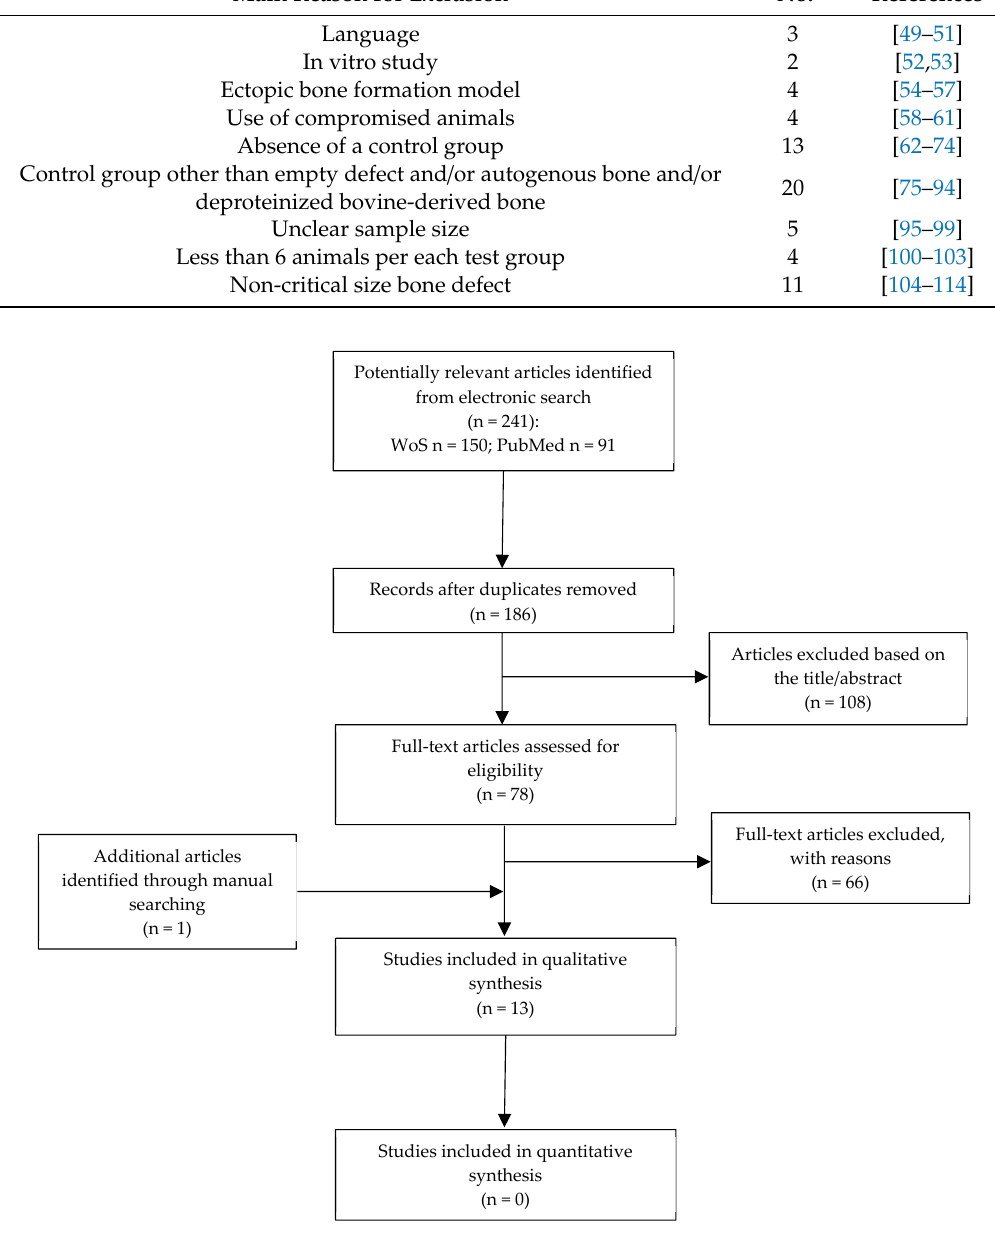
Figure 1. Flowchart of the article selection